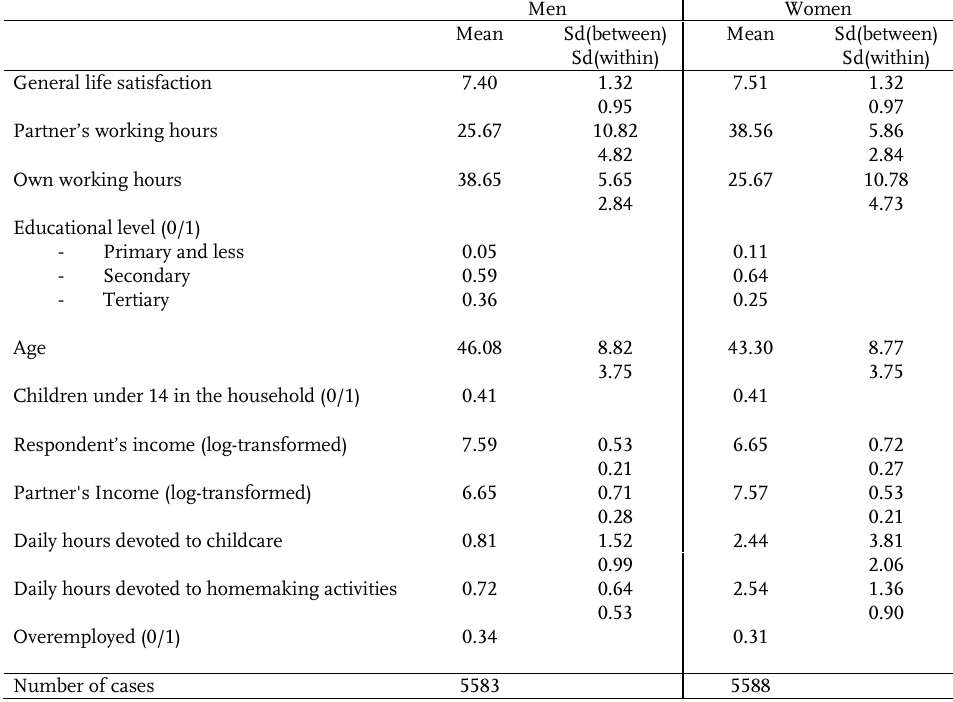
Table 1 : Descriptive statistics (means and standard deviations) by gender